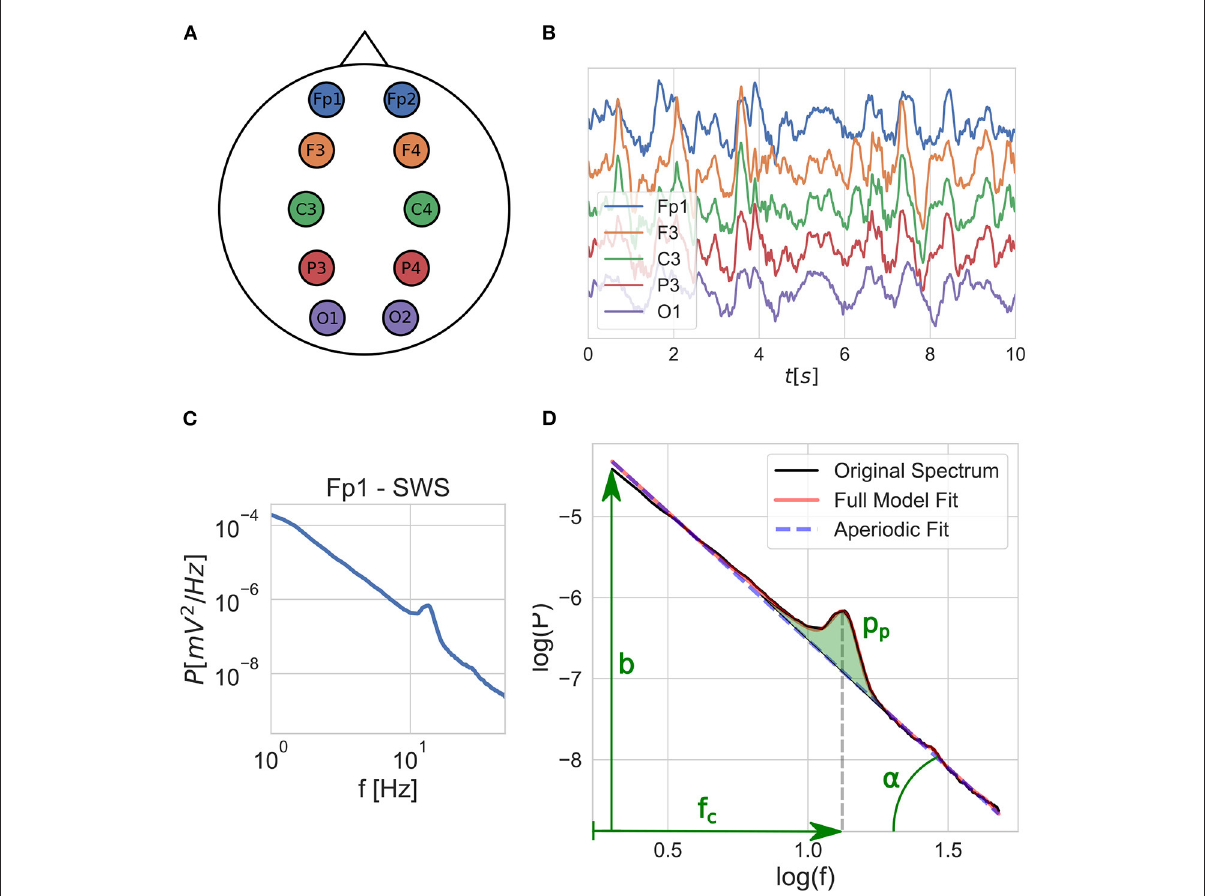
FIGURE1 Schematic outline of the fitting process: (A) EEG is recorded with electrodes placed according to the 10–20 system, out of which 10 are used, covering 5 brain regions on both left and right hemispheres. (B) Time domain signals are segmented into 20 s windows and grouped by sleep stages for each EEG channel. (C) Average power-spectral density is calculated for each sleep stage per channel. (D) The FOOOF model is fitted to the average power spectra, and the model parameters are extracted: spectral slope [ x = tan ( α )], intercept ( b ), peak central frequency ( f c ), and peak power ( p p